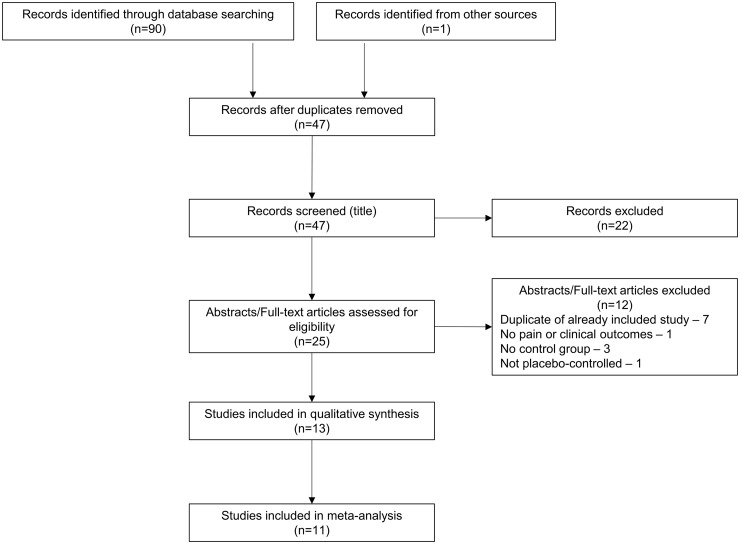
PRISMA flow diagramResults of the literature search.